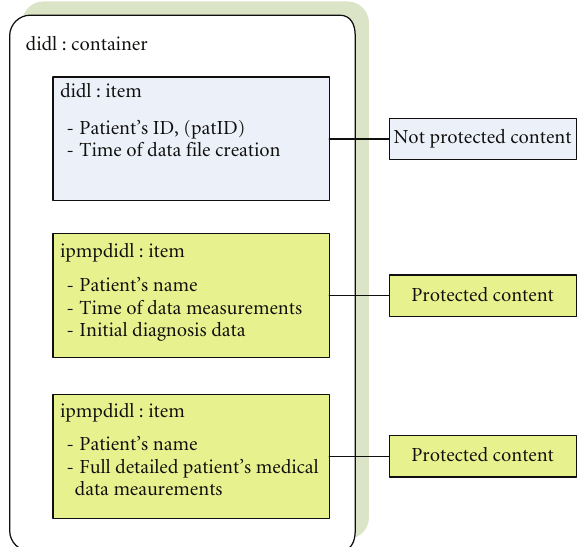
Figure 8: A schematic view of the encapsulated medical data into an MPEG-21 container. The first item is not protected, and it contains some data which can be used by the IT personnel in order to store the protected file into appropriate databases. The second item is protected, and it contains some part of personal data for the patient. Finally, the last item is also protected and includes the detailed medical data measurements. Each item is encrypted using di ff erent encryption keys, so each item can be seen only by users that possess the appropriate key for